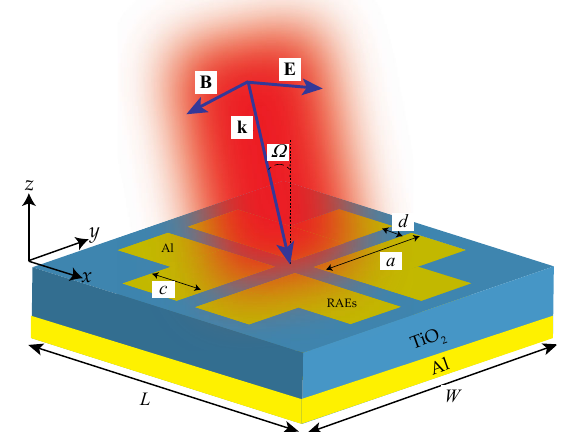
Fig. 1 Schematic diagram of the designed metamaterial absorber. The optimized parameters of RAEs are the following; a = 15 µm, c = 7 µm, and d = 1 µm. The thickness of the whole device is 2.3 µm. A plane wave with a wave vector k is propagating along the negative z -axis incidents at the structure with an incidence angle of Ω . E and B are electric and magnetic fields, respectively, which are perpendicular to k . The thicknesses of TiO 2 and Al layers are 2 µm and 200 nm,